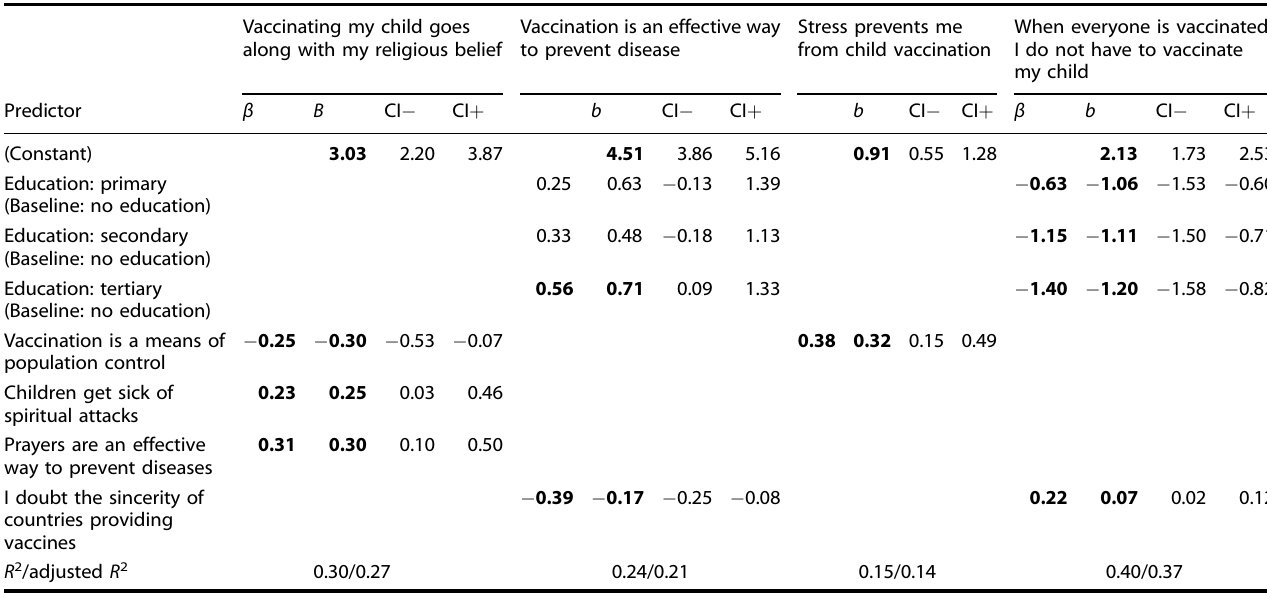
Table 4. Regression